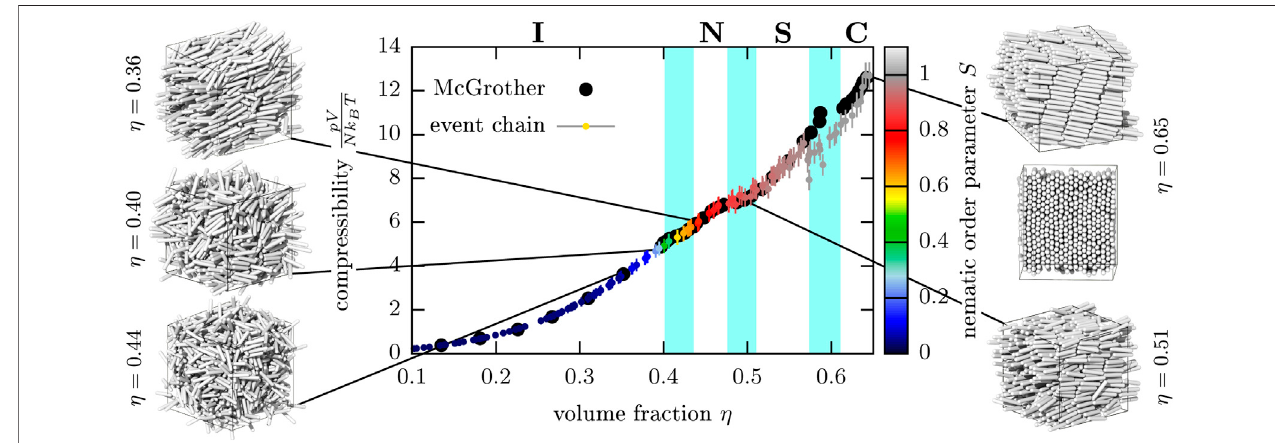
FIGURE 10 | Phase diagram of hard spherocylinders (with diameter D and length L (cid:2) 5 D ) in three dimensions. We see four phases ( I — isotropic, N — nematic, S — smectic, C — crystalline), in agreement with previous results by McGrother et al. [90] We added six snapshots at different volume fractions η to illustrate the different phases and phase transitions (also indicated by the blue